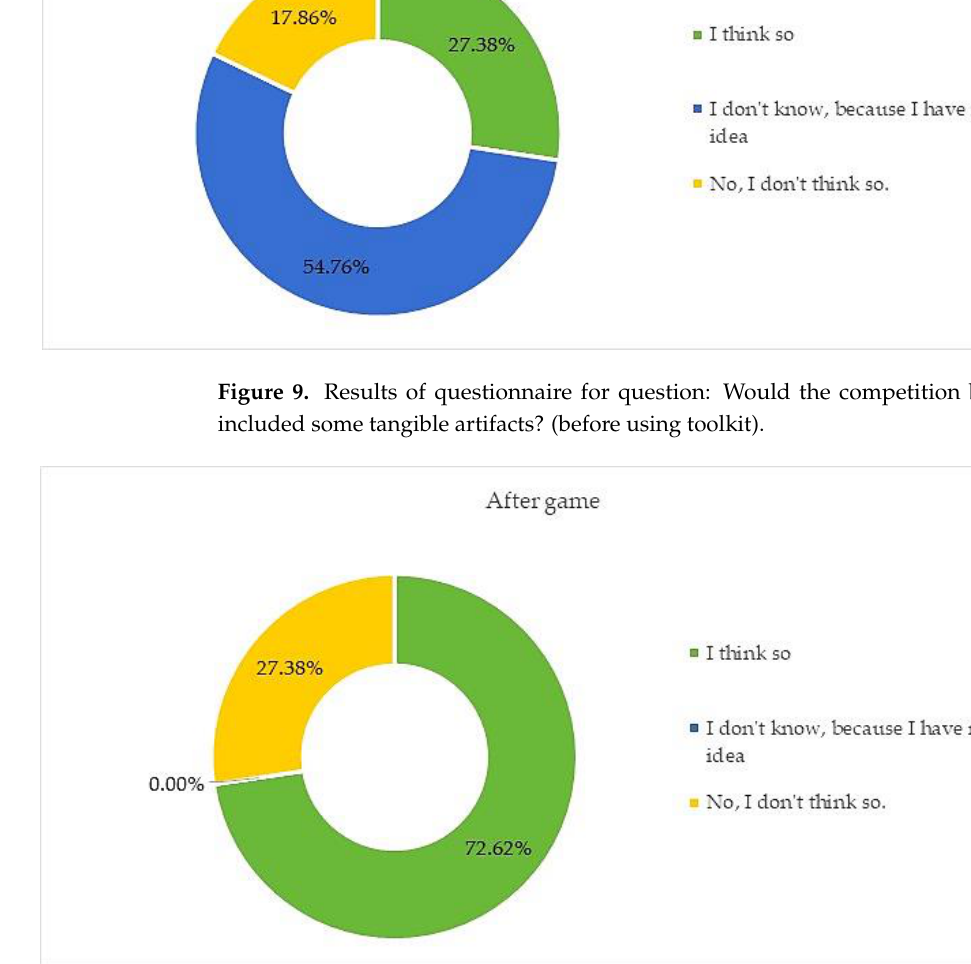
Figure 10. Results of questionnaire for question (Would the competition be more engaging if it included some tangible artifacts?) after using toolkit.